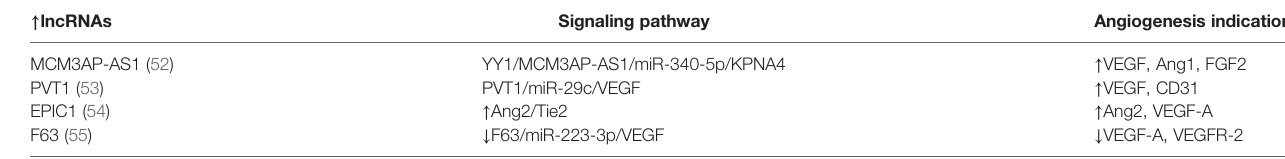
TABLE 2 | Research progress of lncRNAs in angiogenesis in lung